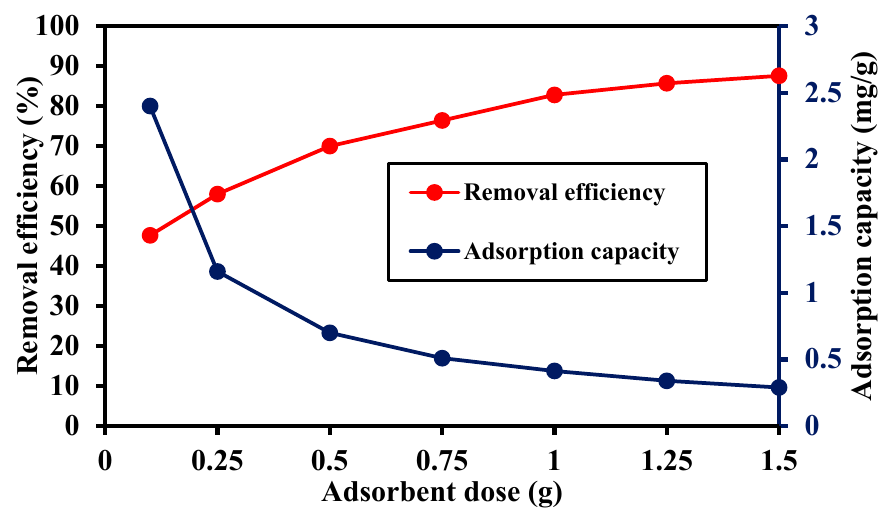
Figure 9. Effect of adsorbent dose on the removal efficiency of trimethoprim antibiotic and the adsorption capacity of Bio-MOF, pH of 7, contact time of 60 min, and adsorbent dose of 0.5 g/L.